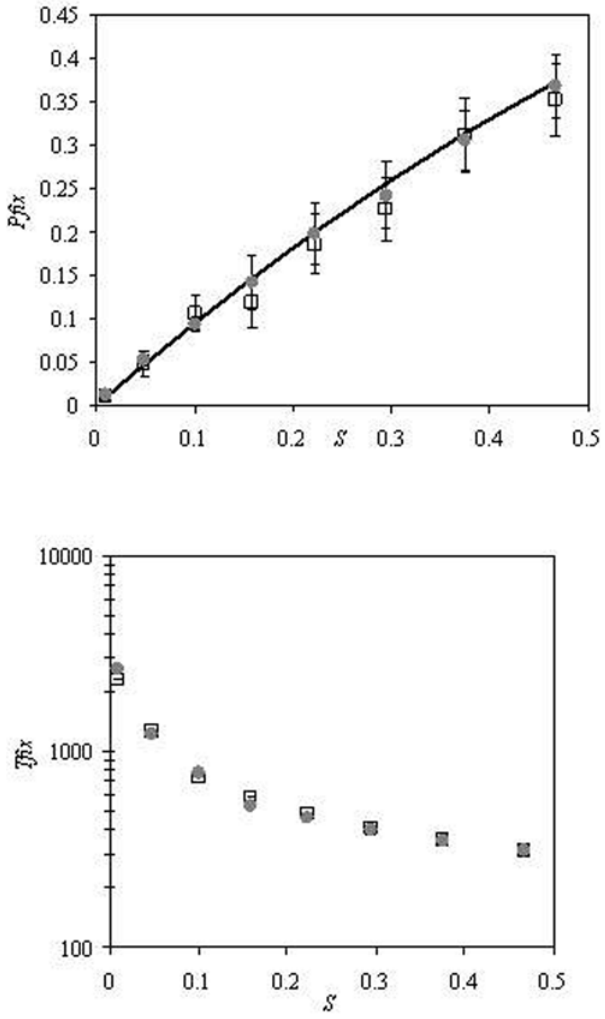
Figure 5. Probability and mean time to replacement. D =5000, b =0.01, e =0.1 and initial R 0 =4.5. There is no reinfection. N d =10 (circles) and N d =20 (squares) A) Probability of replacement of new strain that has selective advantage s ( P fix ). B) Mean time to replacement of new selected strain ( T fix ).